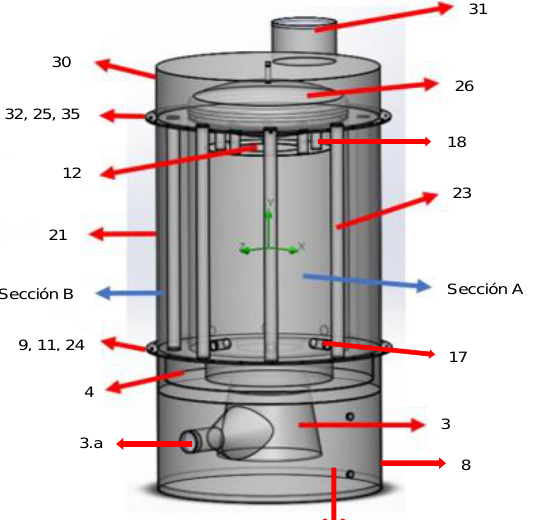
Figure 5. The vertical multipurpose three-pass pyro-water-tube boiler with alternative fuels. Ac- cording to the previous figures, the device comprises: (3) Ignition enclosure; (3.a) Circular income; (4) Circular channel; (8) Sheet metal outer circular base vertical cylinder; (9) Upper circular combus- tion chamber support flange; (11) Tape packing; (12) Cylindrical hearth; (17) Plurality of radial tubes; (18) Short length vertical pipes; (21) Exterior vertical cylinder of metallic plate, conforms section B; (23) Vertical steel tubes; (24) Lower circular flange for water chamber support; 25) Upper circular flange to support the water chamber; (26) Dome; (31) Circular section of the chimney; (32) Round flange of the dome cover; (35) Circular sealing gasket between the flanges of the dome cover and the upper flange of the water chamber.